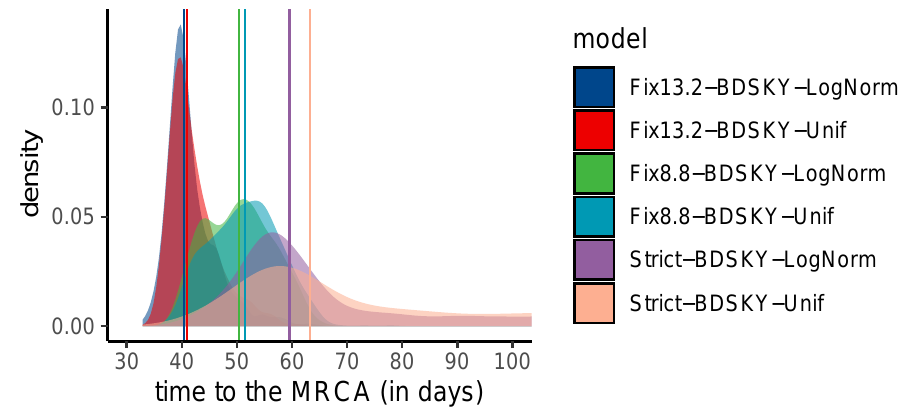
Figure S3 – Time to the MRCA as a function of the molecular clock and of the recovery rate prior. Here we assume BDSKY model. Note that the posterior distributions are not very informative when the molecular clock value is estimated (the ‘Strict’